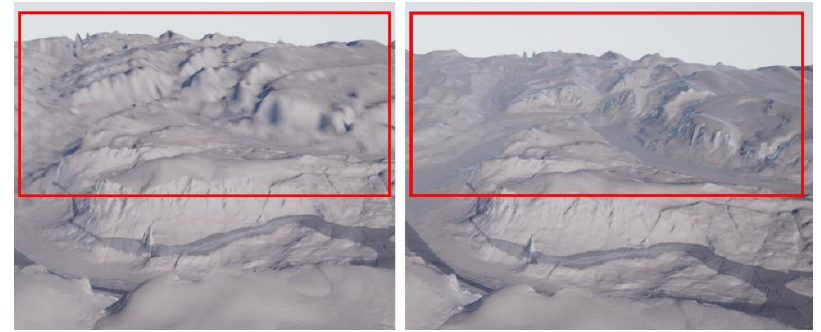
Figure 6. Distant terrain without normal texture ( left ) and with normal texture ( right ).